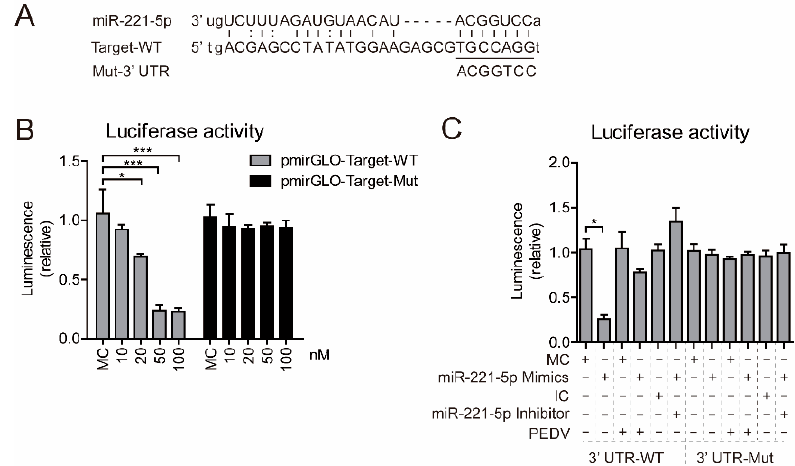
Figure 4. miR-221-5p directly targets the 3 ′ untranslated region (UTR) of PEDV genomic RNA. ( A ) Diagram of the predicted miR-221-5p-binding site in PEDV genomic RNA. Seed sequences of miR-221-5p are underlined, and mutated sequences are shown. ( B ) Luciferase activity in MARC-145 cells were co-transfected with wild type (WT) (pmirGLO-Target-WT) or mutant (pmirGLO-Target-Mut) luciferase-reporter vector, along with different concentrations of miR-221-5p mimics (10, 20, 50, and 100 nM) for 24 h. ( C ) Luciferase activity in MARC-145 cells in the presence or absence of PEDV CH/HBTS/2017 infection at an MOI of 0.1 for 2 h, followed by co-transfection with miR-221-5p mimics or an miR-221-5p inhibitor. Data in ( B , C ) represent the mean ± SD of three independent experiments and measured in technical duplicate. Comparisons between groups were determined by Student’s t test. * p < 0.05; ** p < 0.01; *** p < 0.001 (Student’s t test). “+” treated; ” − “ untreated.